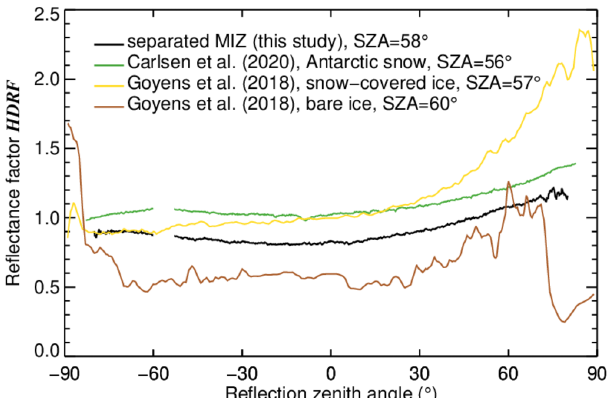
Figure 9. Comparison of the cross-sections of the HDRF of snow, snow-covered, and bare sea ice along the solar principal plane ob- tained from different studies (color-coded); see text for